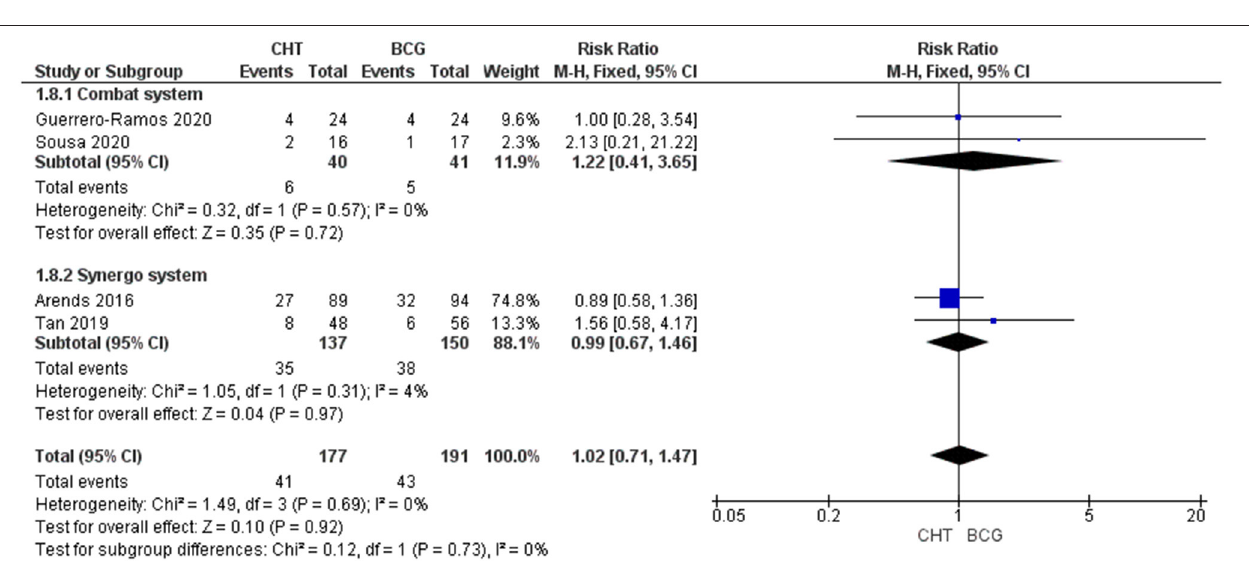
FIGURE 5 | Grade 3 or above adverse events stratified by the type of chemohyperthermia